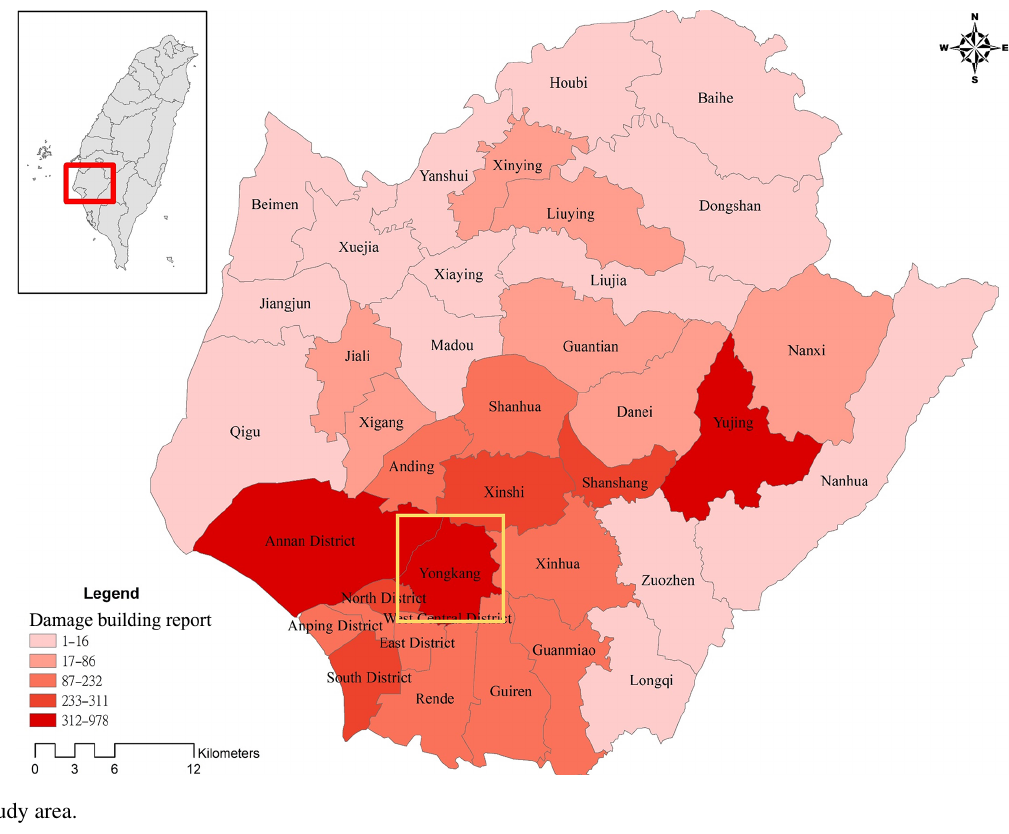
Figure 1. Study area. Table 1. Measurement of the questionnaires. Aspects Items Predisaster Postdisaster Risk perceptions Probability of an earthquake disaster occurring 7-point within the next 10 years Fear of earthquakes 7-point Worries over buildings